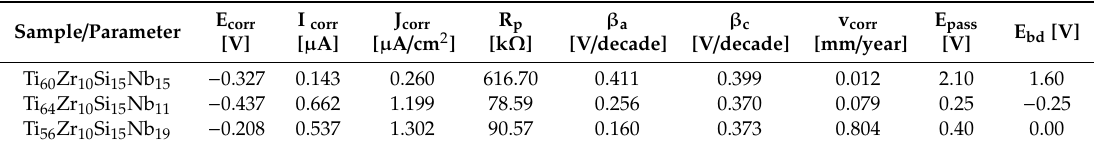
Figure 14. Evans diagrams in NaCl 0.9% for bulk alloy samples. Table 5. Corrosion parameters in NaCl 0.9%.